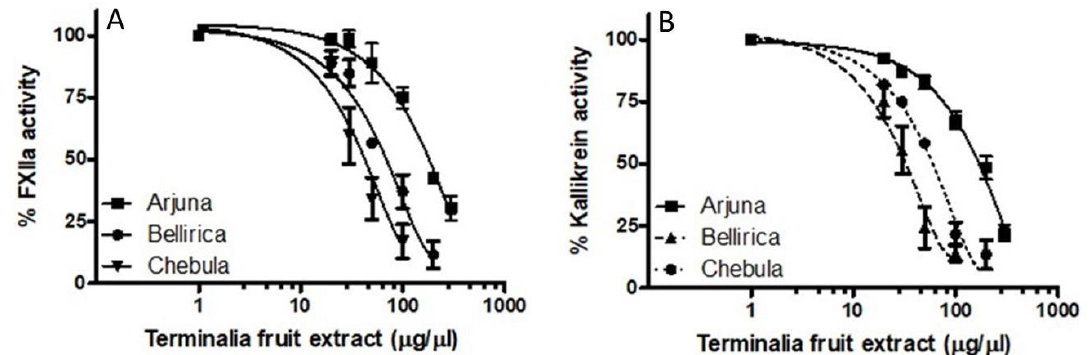
Figure 5. Effect of Terminalia fruit extract on plasma kallikrein activity. Increasing concentrations (1–500 µ g/ µ L) of Terminalia fruit extract were incubated with activated factor XII (17 nM), ( A ) kallikrein ( B ) and S2302 for 1 h at 37 ◦ C. For all panels, results represent means for three runs.